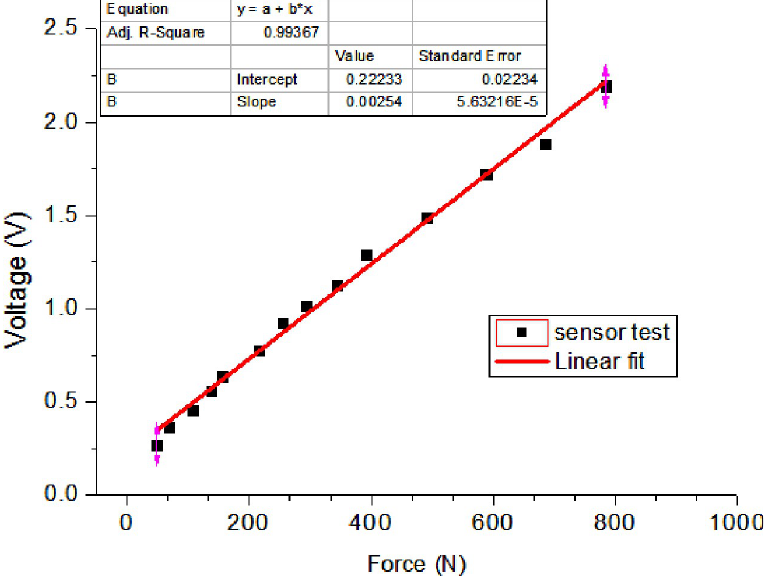
Fig 4. Relationship between the cell voltage and the external applied force for the 11th cell of the flexible sensor matrix film.